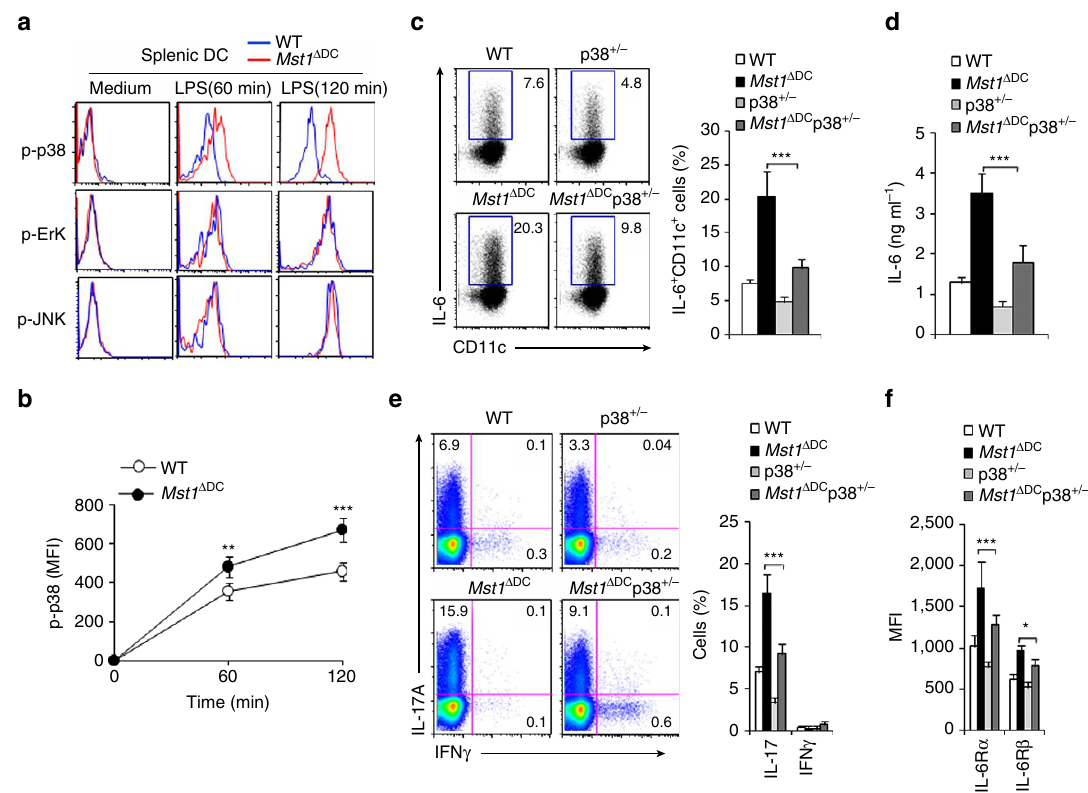
Figure 8 | MST1 regulates IL-6 production through p38MAPK. ( a ) Intercellular staining of the indicated proteins in splenic DCs following LPS stimulation in vitro . Expression of the phosphorylation of p38MAPK (MFI) among CD11c þ cells is summarized in b . ( c , d ) Intracellular staining of IL-6 in DC isolated from the indicated mice 4h after the i.p. injection of 10mgkg (cid:2) 1 LPS ( c ). Right, the proportion of IL-6 þ cells in DCs is summarized. The serum IL-6 level in the indicated mice ( d ). ( e ) Intracellular staining of IL-17 and IFN g in Tcells co-cultured with splenic DCs isolated from indicated mice was determined with FCM. Right, proportion of IL-17 and IFN g in CD4 þ Tcells is summarized. ( f ) Expression of the indicated gene in Tcells was determined with FCM